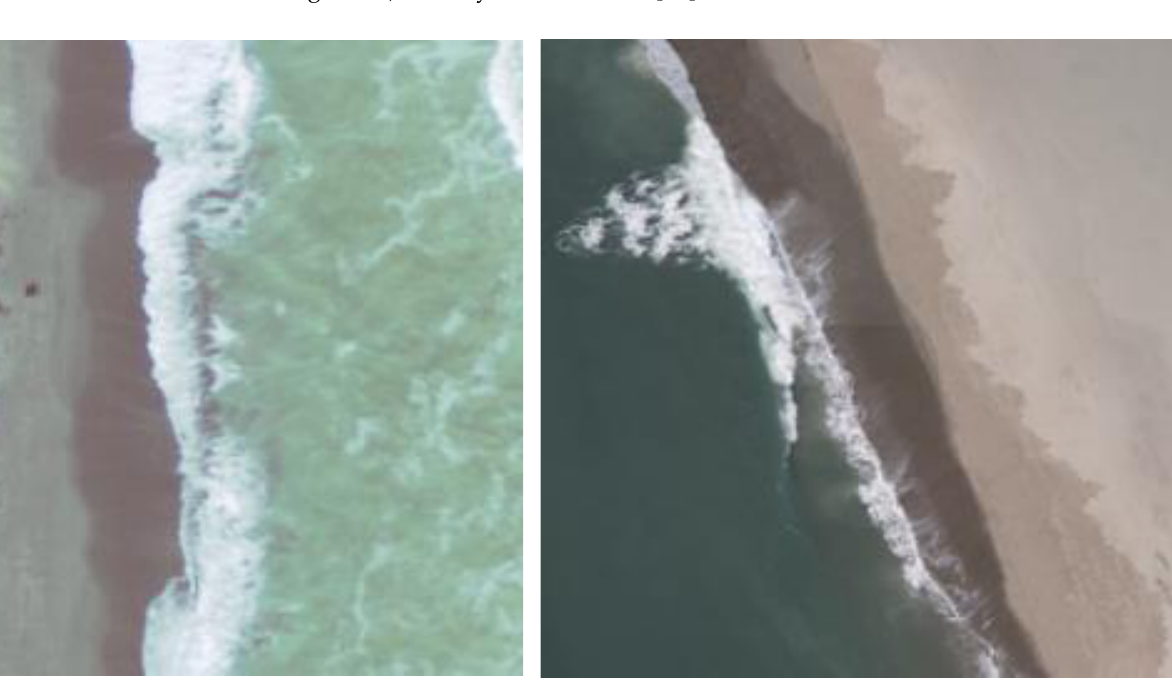
Table 4. Stat istical data for comparison of compression variants’ performance characteristics ( PSNR tc ).